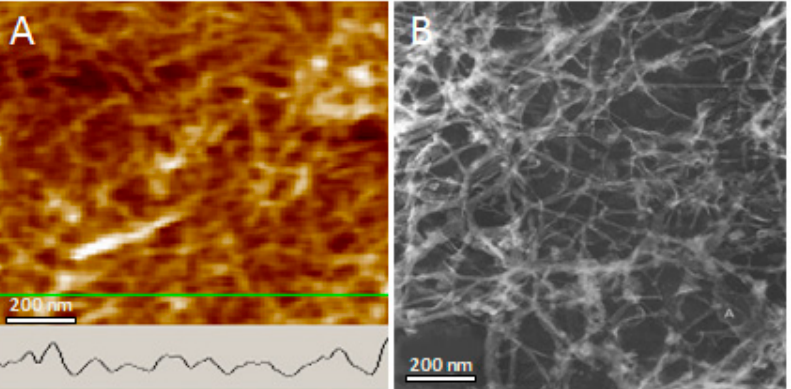
Figure 5. Network formed by lysozyme amyloid fibers (AFM, topographic view) and by tau neurofibrillary tangles (TEM image from Ruben, 1997). The AFM profile of lysozyme fiber is shown (inset). Distance between fibers and pore size is similar in both. Merging of fibers at points of contact suggest coiling of fibers with each other in both cases.